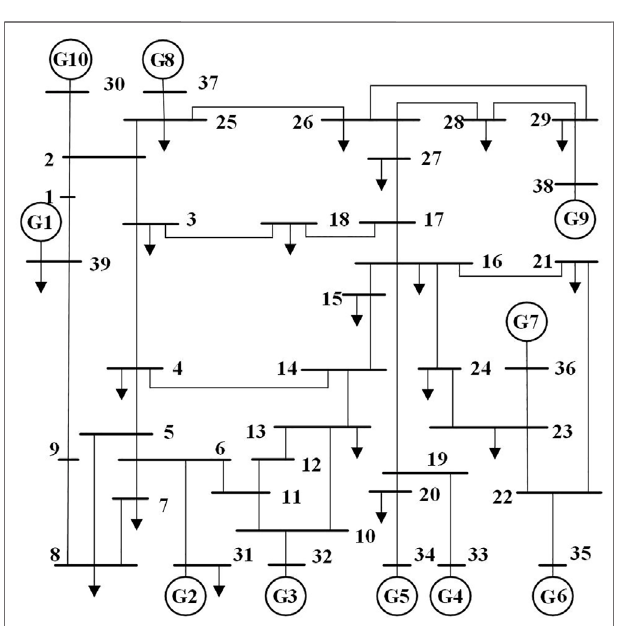
FIGURE 5 | New England 10-machine 39-bus power system.